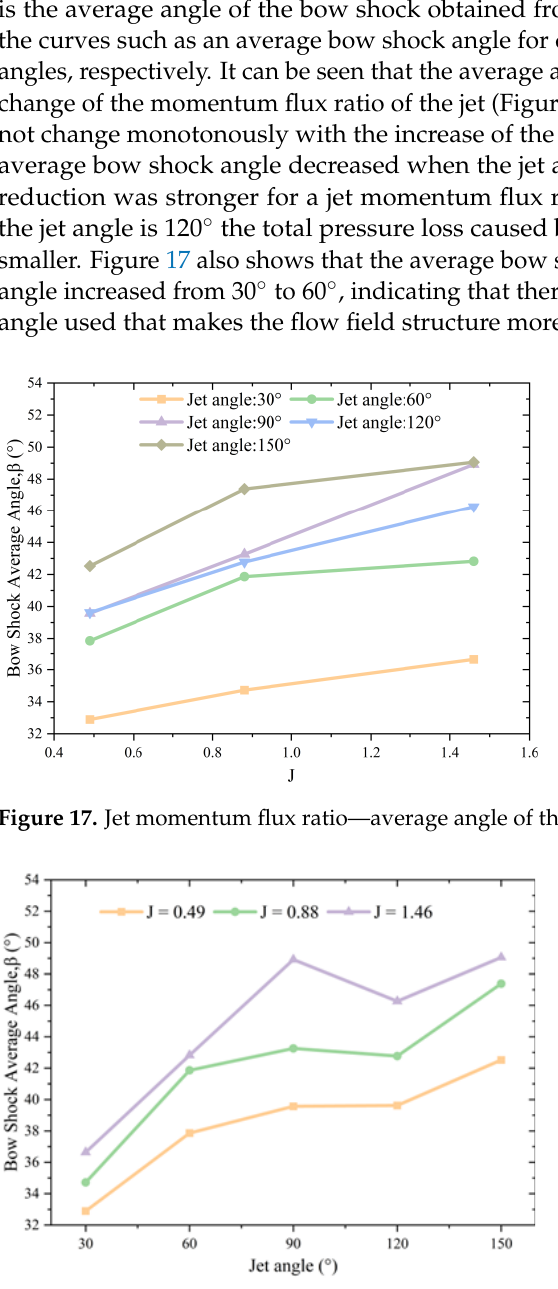
Figure 18. Jet angle — average angle of the bow shock.